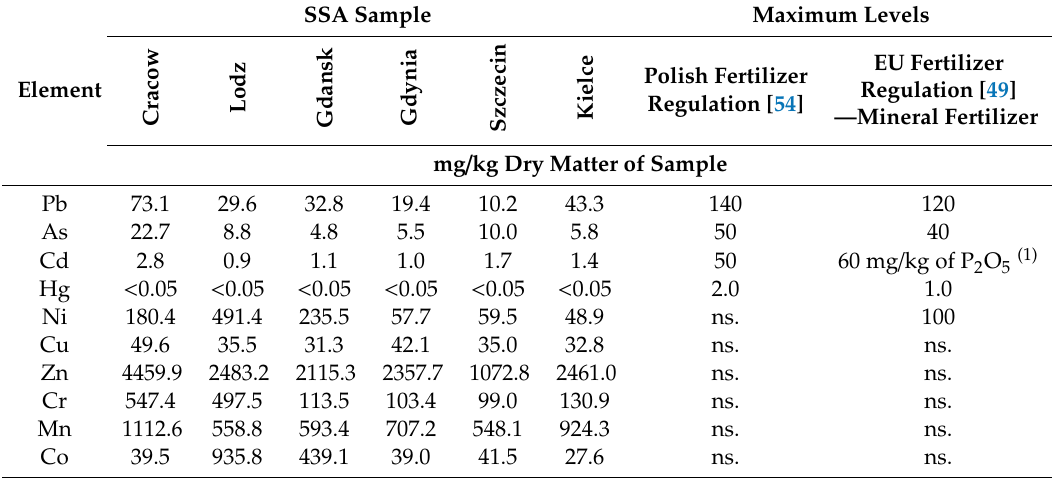
Table 5. Content of heavy metals in the thermochemically treated SSA compared with the heavy metal limiting values that apply to mineral